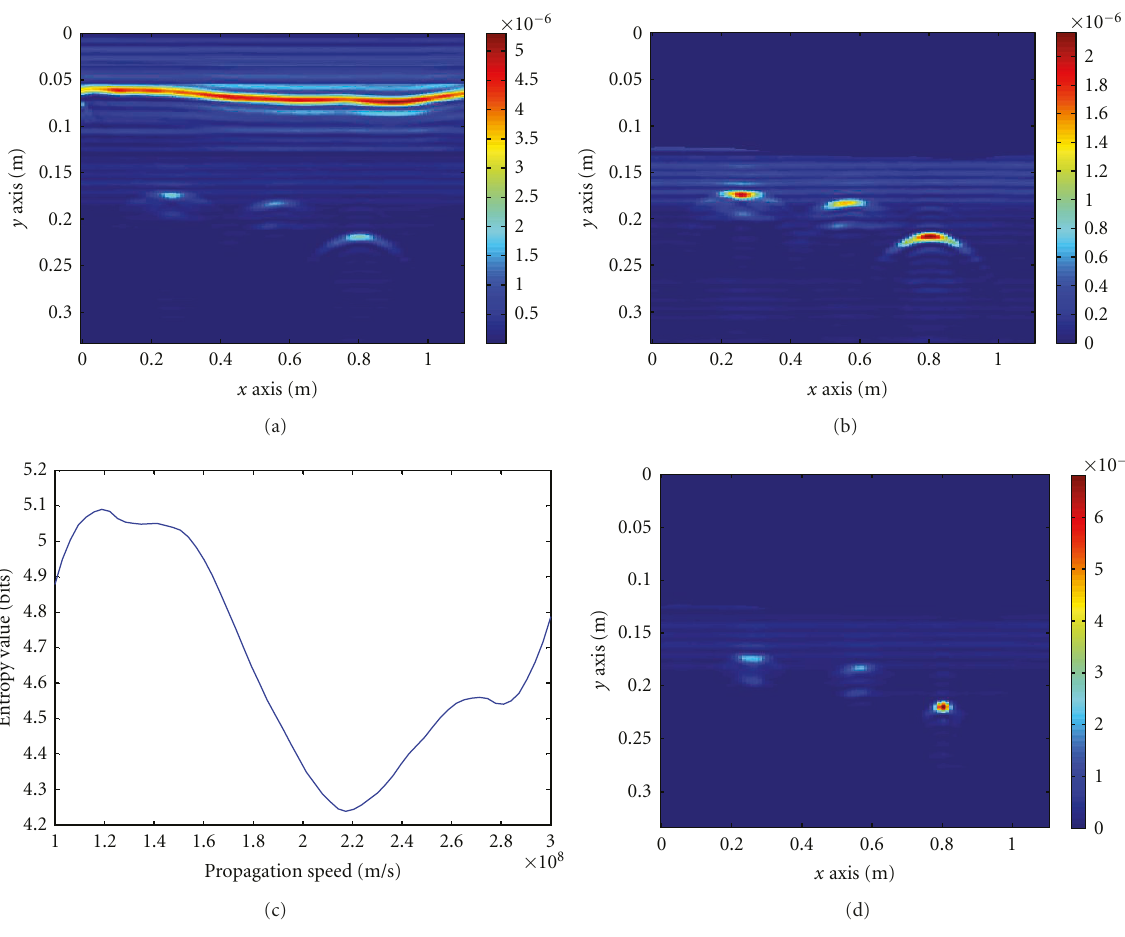
Figure 12: (a) Third experimental data set. (b) Denoised data set. (c) Entropy values for the interval [1 × 10 8 m/s, 3 × 10 8 m/s]. (d) Dataset reconstructed using v ∗ . Table 3: Estimation errors and execution times of the proposed method and the HT-based estimation technique for each experimental data